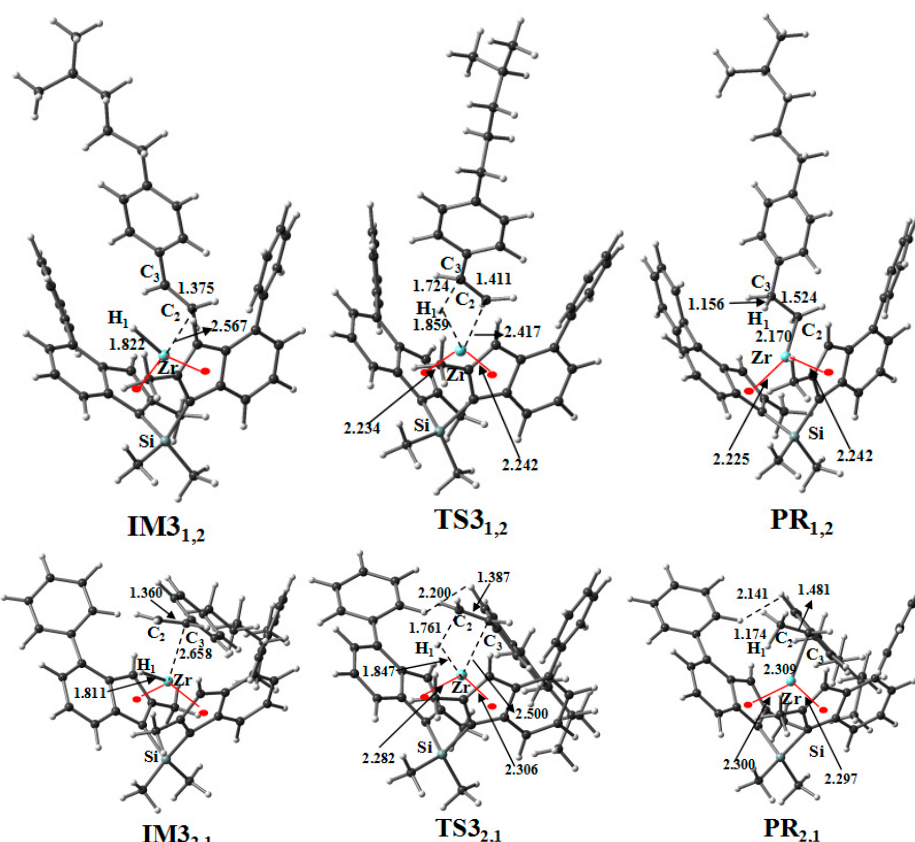
Figure 6. Optimized structures of key TSs and intermediates (IMs) in the DVB reaction pathway shown in Figure 5. The key length is in angstroms.